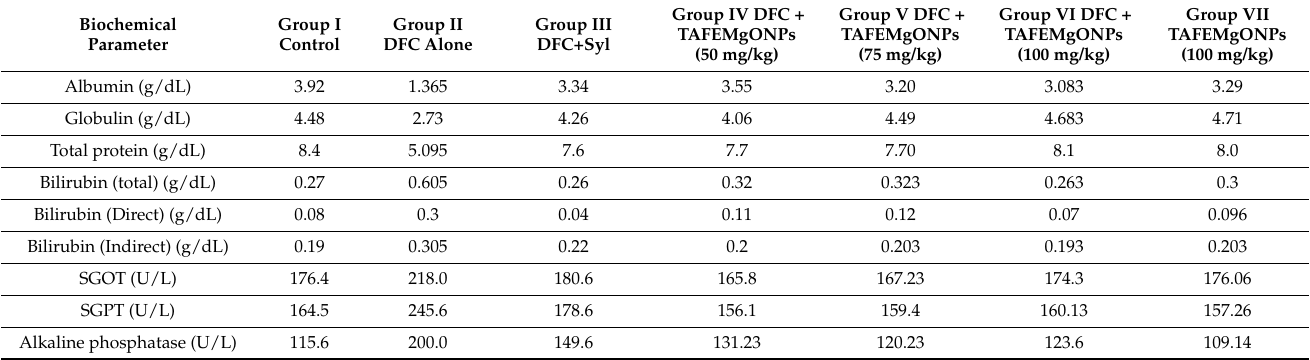
Table 1. Effect of TAFEMgO NPs on biochemical parameters in Sprague Dawley (75 – 100 g) male rats.